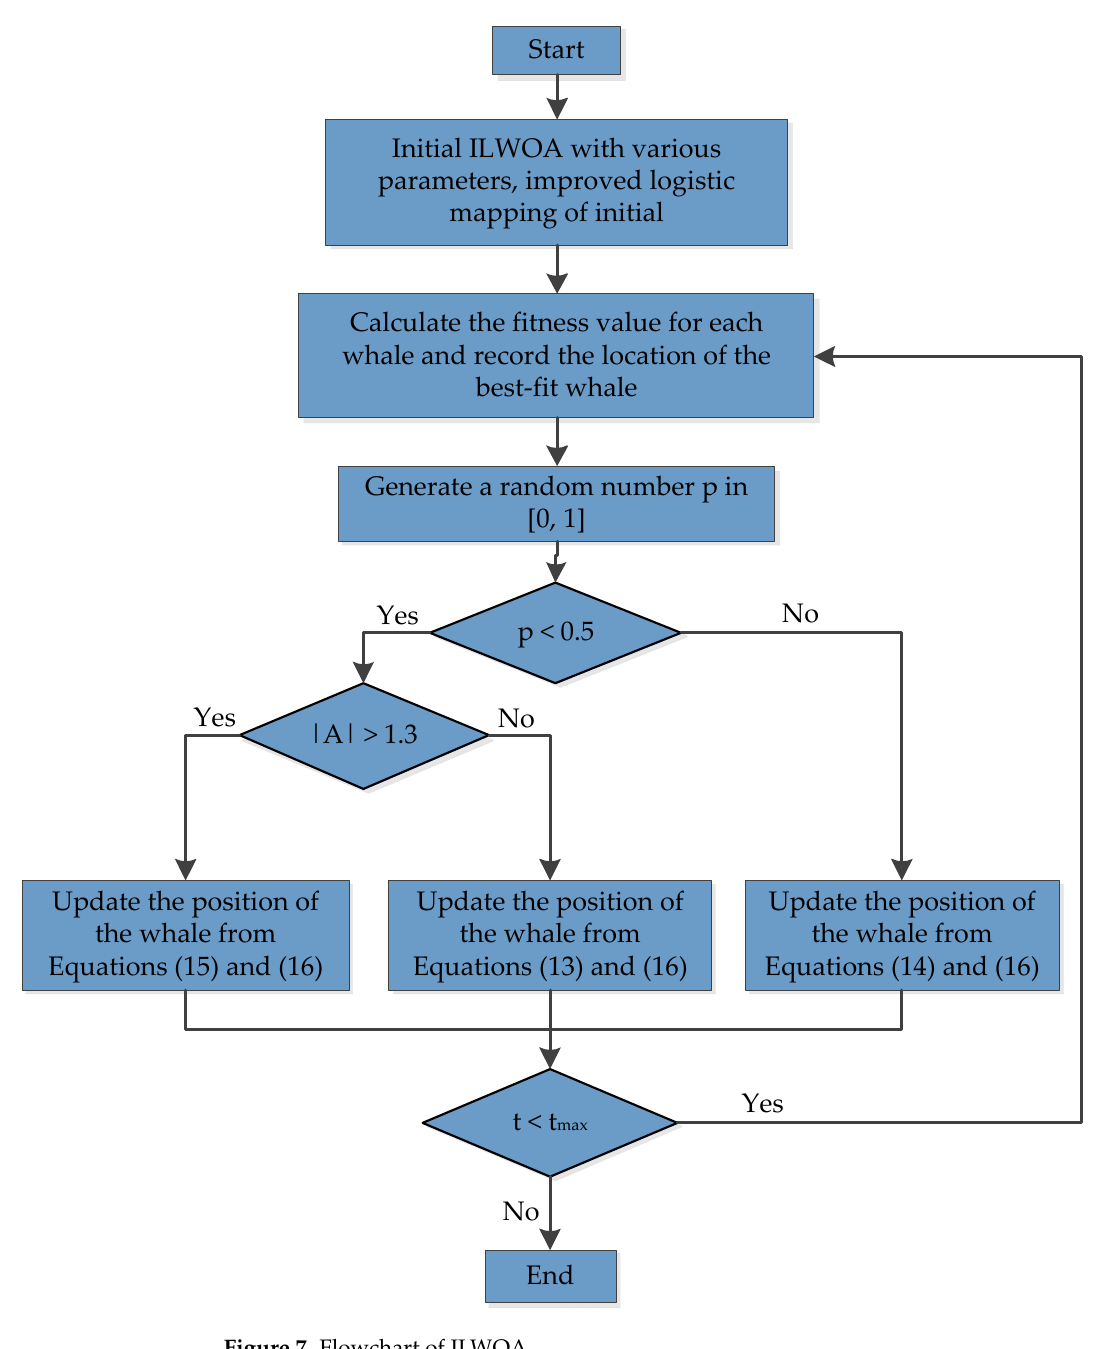
Figure 7. Flowchart of ILWOA.